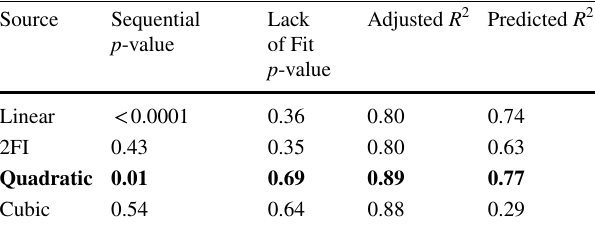
Table 3 Statistical adequacy evaluation of models